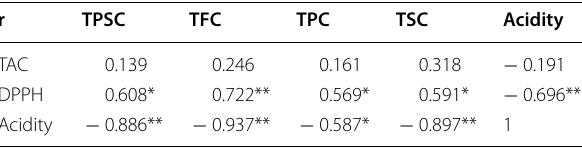
r: Pearson’s correlation coefficient * P <